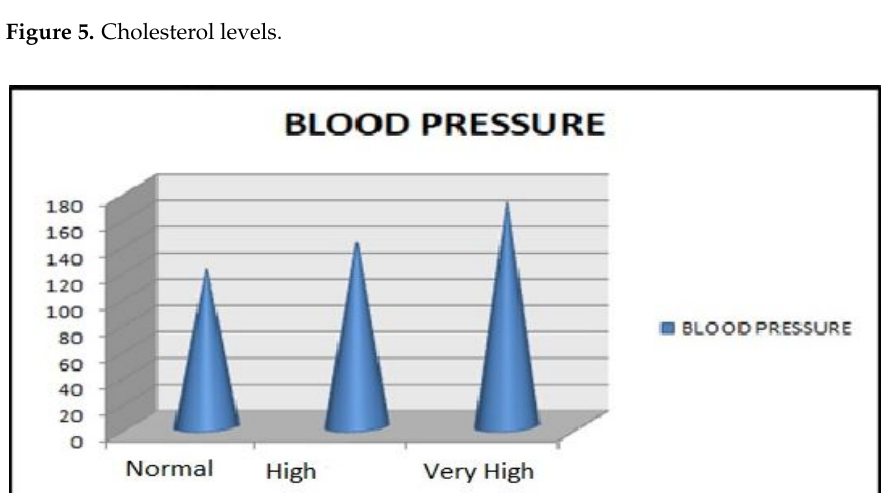
Figure 6. Blood pressure levels.